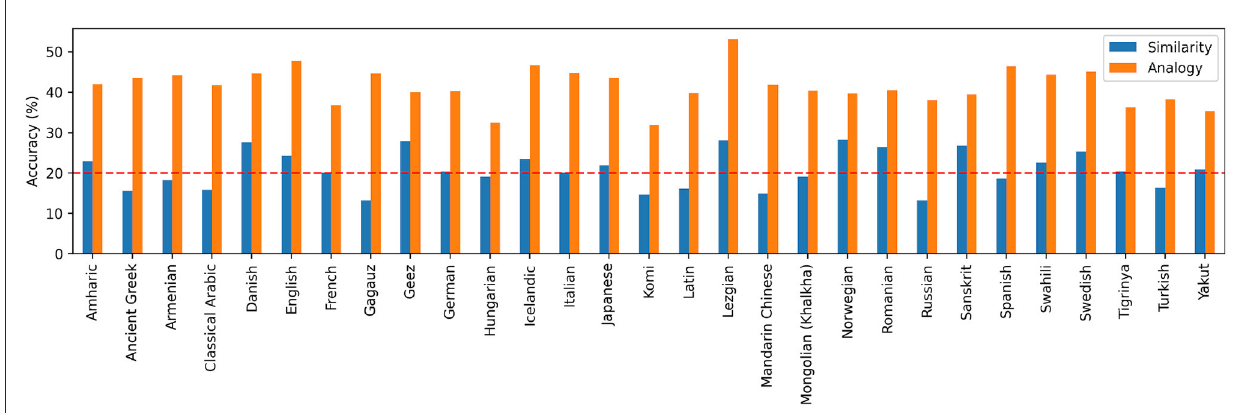
geological formation, and meanings to do with everyday actions shifting toward meanings to do with politically destructive